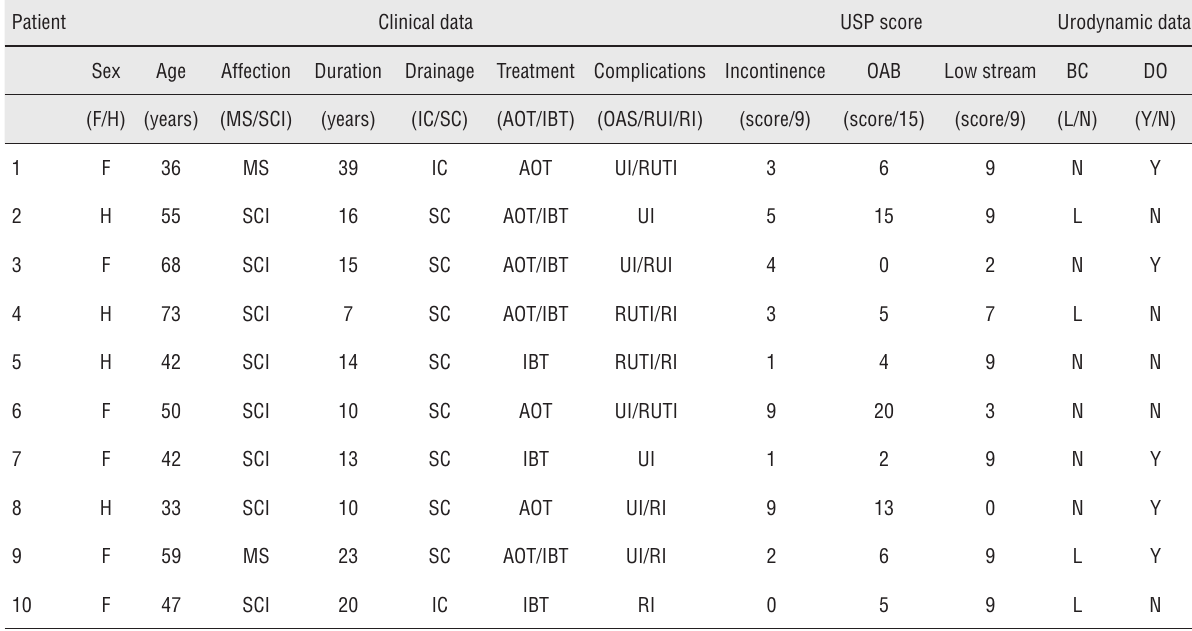
Table 1 - Clinical and urodynamic data of the patients group. Patient Clinical